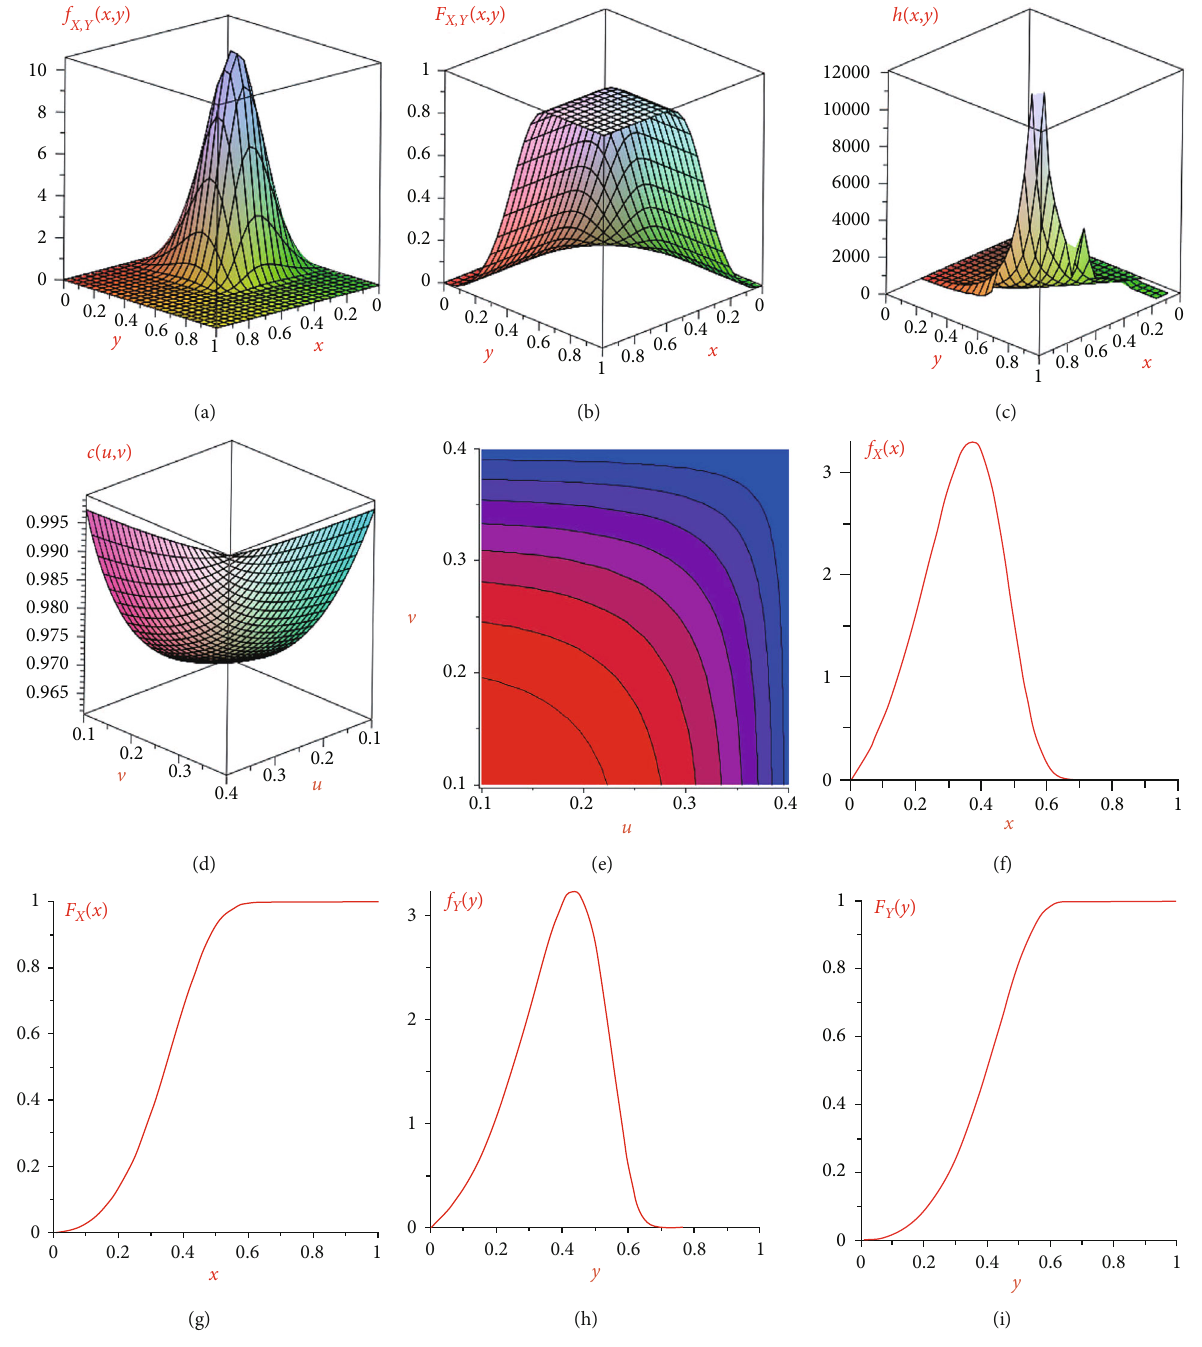
Figure 17: Statistical quantities for ð X , Y Þ ~ BIUPW ð 0 : 6,1 : 4,2 : 0,0 : 3, − 0 : 4,0 : 5 Þ